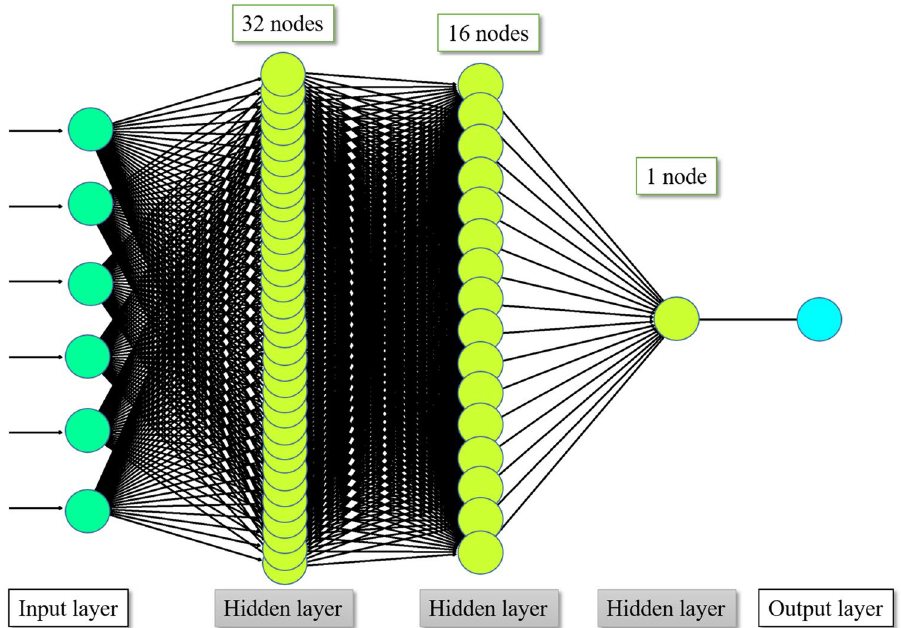
of training samples is presented to the network, a loss function measures the inaccuracy of the computed prediction. All parameters are then slightly updated in the direction that will minimize the error, a process called